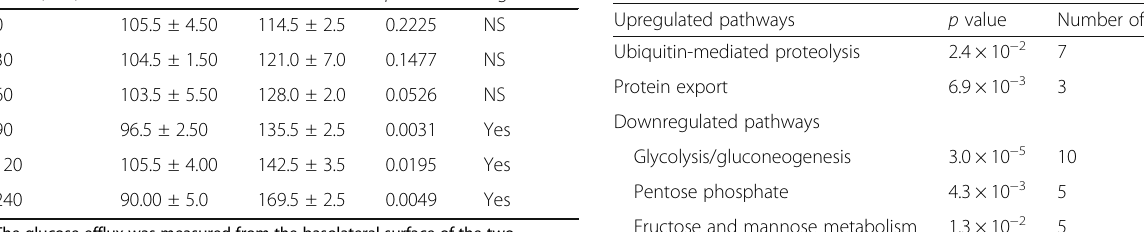
Table 2 Cellular glucose efflux